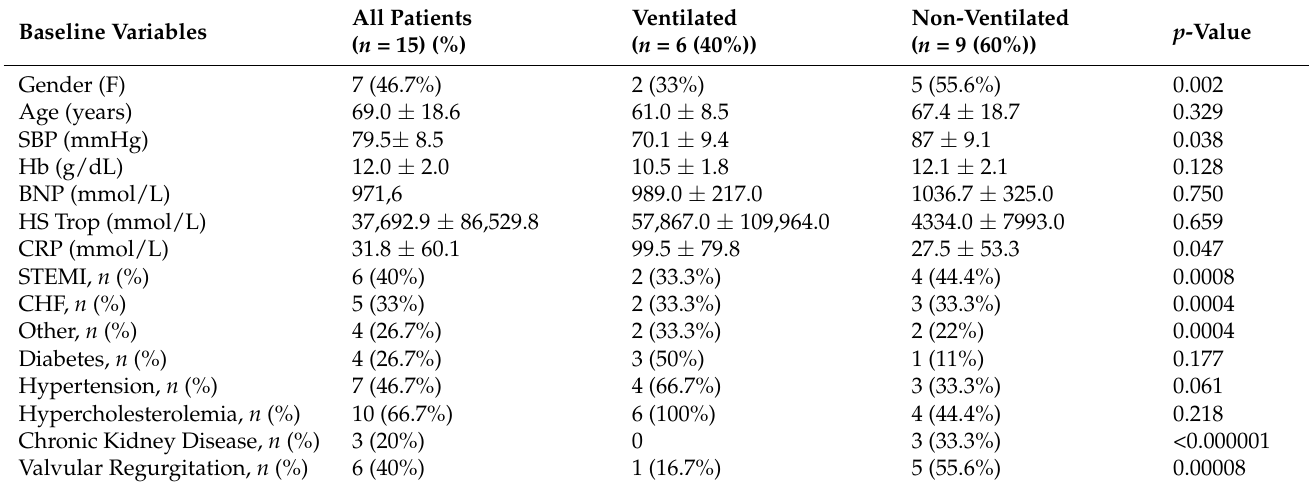
Table 1. Main characteristics of the whole study population, divided by ventilated and non-ventilated